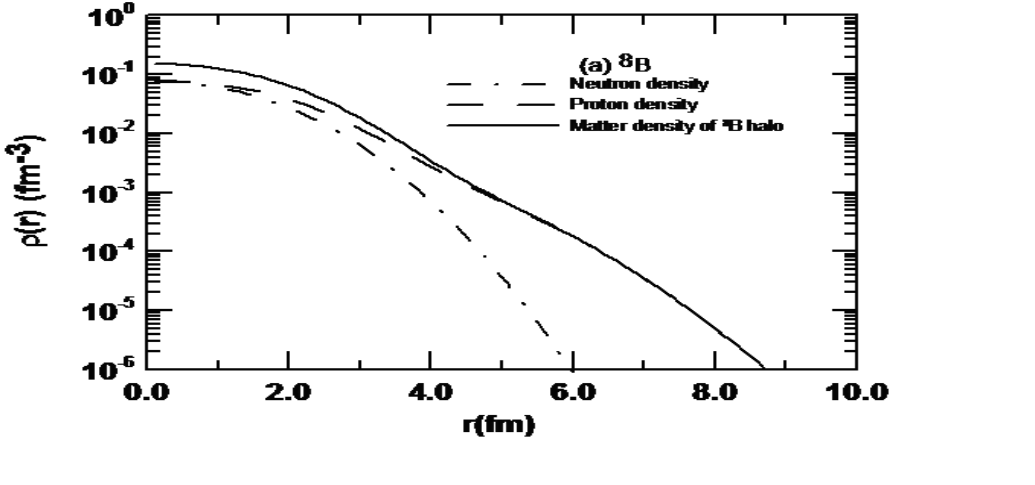
Fig.2: (a) The contributions of proton and neutron density to matter density of 8 B halo